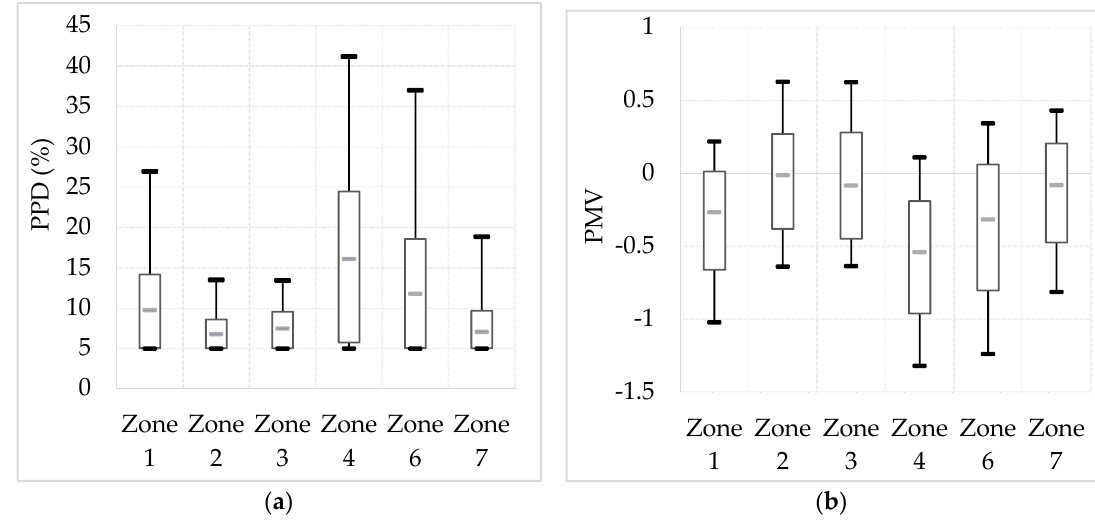
Figure 7. Median, minimal, maximal and (10th–90th) percentiles of: ( a ) the PPD (predicted percentage of dissatisfied); and ( b ) the PMV (predicted mean vote) for each zone for the month of January.